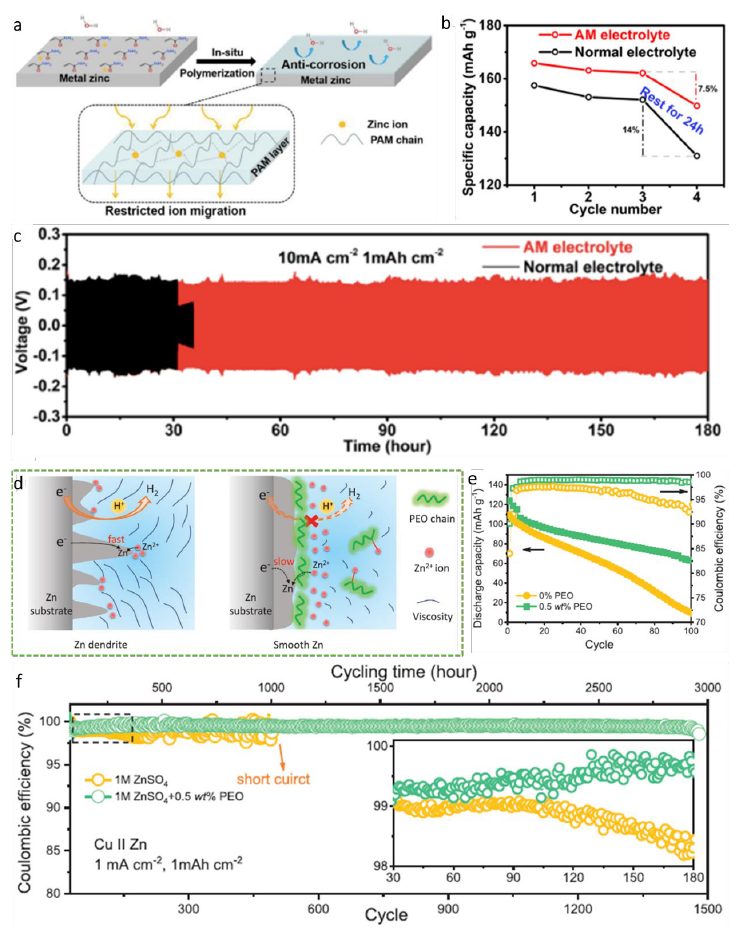
Figure 15. ( a ) Schematic description of zinc deposition with PAM electrolyte additive, ( b ) self-discharge tests by standing for 24 h after fully charged, and ( c ) cycling performance of symmetric cells at 10 mA cm -2 for 1 mA h cm -2 . (Reproduced with permission. [172] Copyright 2021, Elsevier). ( d ) Schematic illustration of Zn deposition with dendritic surfaces and hydrogen evolution, ( e ) cycling stability and Coulombic efficiency of Zn ǁ LiMn 2 O 4 cells at 0.5 C with and without PEO additive, and ( f ) Coulombic efficiency and cycling performance of Zn metals in Cu ǁ Zn cells under a current density of 1 mA cm − 2 for 1 mAh cm − 2 . (Reproduced with permission. [176] Copyright 2020, John Wiley & Son).